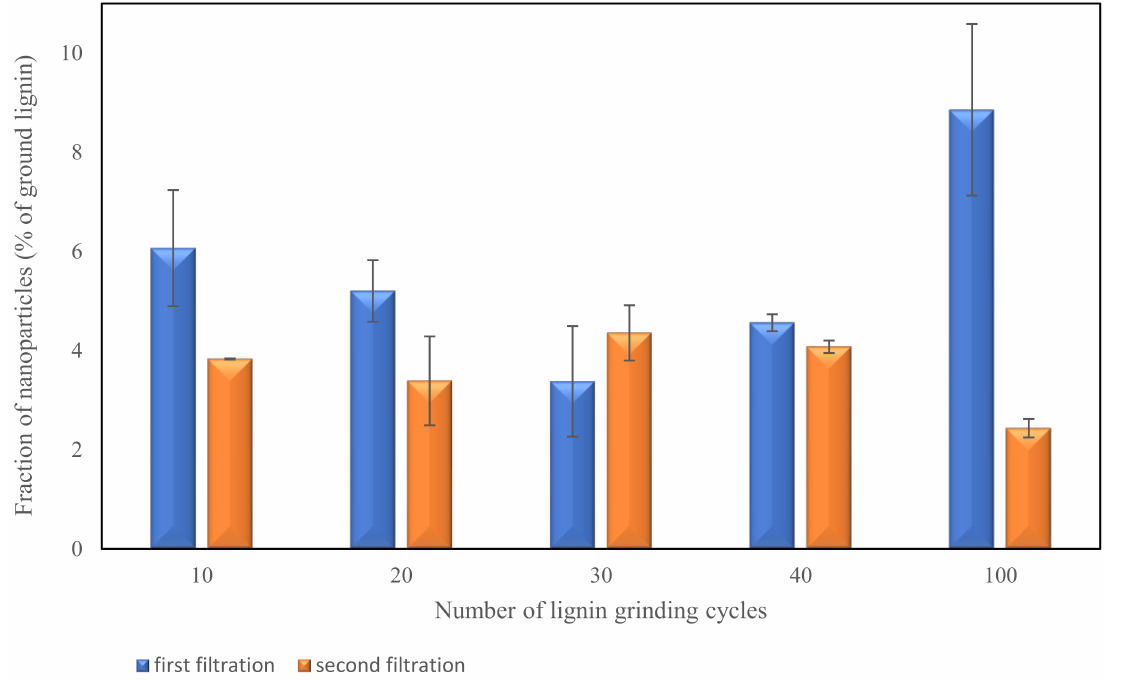
Figure 3. Fraction of lignin nanoparticles in ground lignin suspension measured in two filtration steps for different grinding